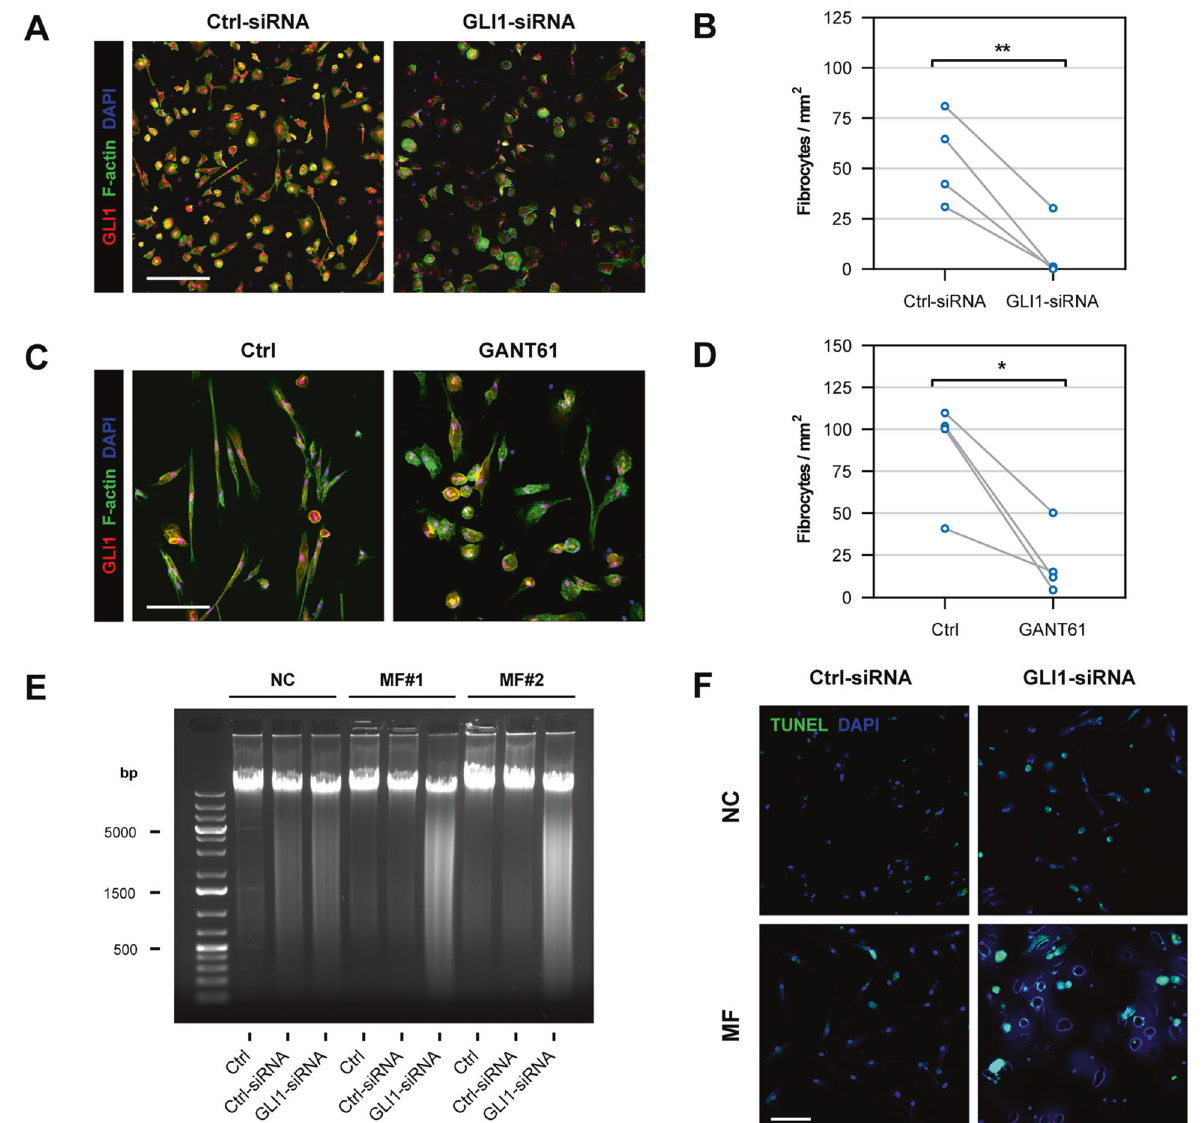
Fig. 4 Inhibition of GLI1 induces apoptosis of MF fi brocytes. A Representative micrographs of MF BM LDC-derived fi brocytes transfected with GLI1-siRNA or Ctrl-siRNA were analyzed by fl uorescence immunostaining. Fibrocytes were cultured from BM LDCs of MF patients and transfected with GLI1-siRNA for 48 h. Cells were stained for GLI1 (Alexa Fluor 594, pseudo-colored red) and F-actin (Alexa Fluor 488, pseudo- colored green) with DAPI (pseudo-colored blue) as a nuclear counterstain. B Quantitation of fi brocytes from MF patients ( n = 4) following GLI1 silencing showed that GLI1-siRNA induced a signi fi cant reduction in fi brocyte counts. Fibrocyte counts were assessed by using an unsupervised cell segmentation algorithm, and the mean cell number per unit area was calculated for each well. The paired t -test assessed the statistical signi fi cance of differences between matched samples. C Representative micrographs of GANT61-treated MF BM LDC-derived fi brocytes analyzed by fl uorescence immunostaining. Cultured viable and morphologically intact fi brocytes were incubated with 10 µM GANT61 for 72 h. Cells were stained for GLI1 (Alexa Fluor 594, pseudo-colored red) and F-actin (Alexa Fluor 488, pseudo-colored green) with DAPI (pseudo-colored blue) as a nuclear counterstain. D Quantitation of fi brocytes from MF patients ( n = 4) following treatment with GANT61 showed that GANT61 signi fi cantly reduced fi brocyte numbers. An unsupervised cell segmentation algorithm determined fi brocyte numbers per unit area, and the means in each well were calculated. Matched values were compared using the paired t -test. E DNA laddering analysis of GLI1-silenced fi brocytes. Fibrocytes were cultured from BM LDCs of MF patients ( n = 2) and BM LDCs of an NC and transfected with GLI1-siRNA or Ctrl-siRNA. Total genomic (g) DNA was isolated and 0.5 µg of gDNA was separated using agarose gel electrophoresis. DNA fragmentation observed in GLI1-silenced MF fi brocytes suggests that GLI1-siRNA, but not Ctrl-siRNA, signi fi cantly reduced fi brocyte viability. F The panel depicts representative micrographs of fi brocyte apoptosis rates assessed by TUNEL staining. High levels of biotinylated dNTPs (Alexa Fluor 488, pseudo-colored green) were detected in MF fi brocytes transfected with GLI1-siRNA. In contrast, biotinylated dNTPs were not detected in NC fi brocytes transfected with GLI1-siRNA or in MF fi brocytes transfected with Ctrl-siRNA. In addition, cell nuclei (stained with DAPI, pseudo-colored blue) show signs of karyorrhexis not observed in NC fi brocytes or fi brocytes transfected with Ctrl-siRNA. All micrographs were adjusted for brightness and contrast linearly and equally between groups. Scale bars represent 100 µm. * P < 0.05; ** P < 0.01,